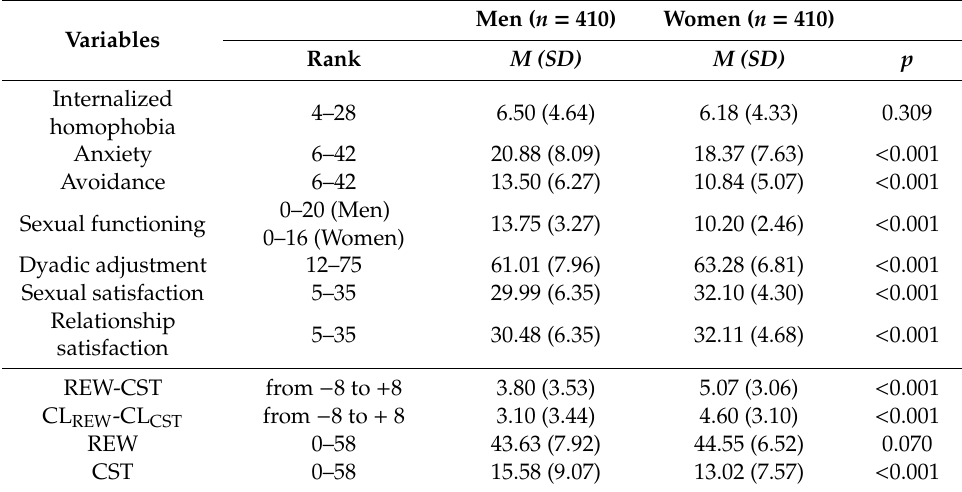
Table 2. Comparisons by sex of the evaluated